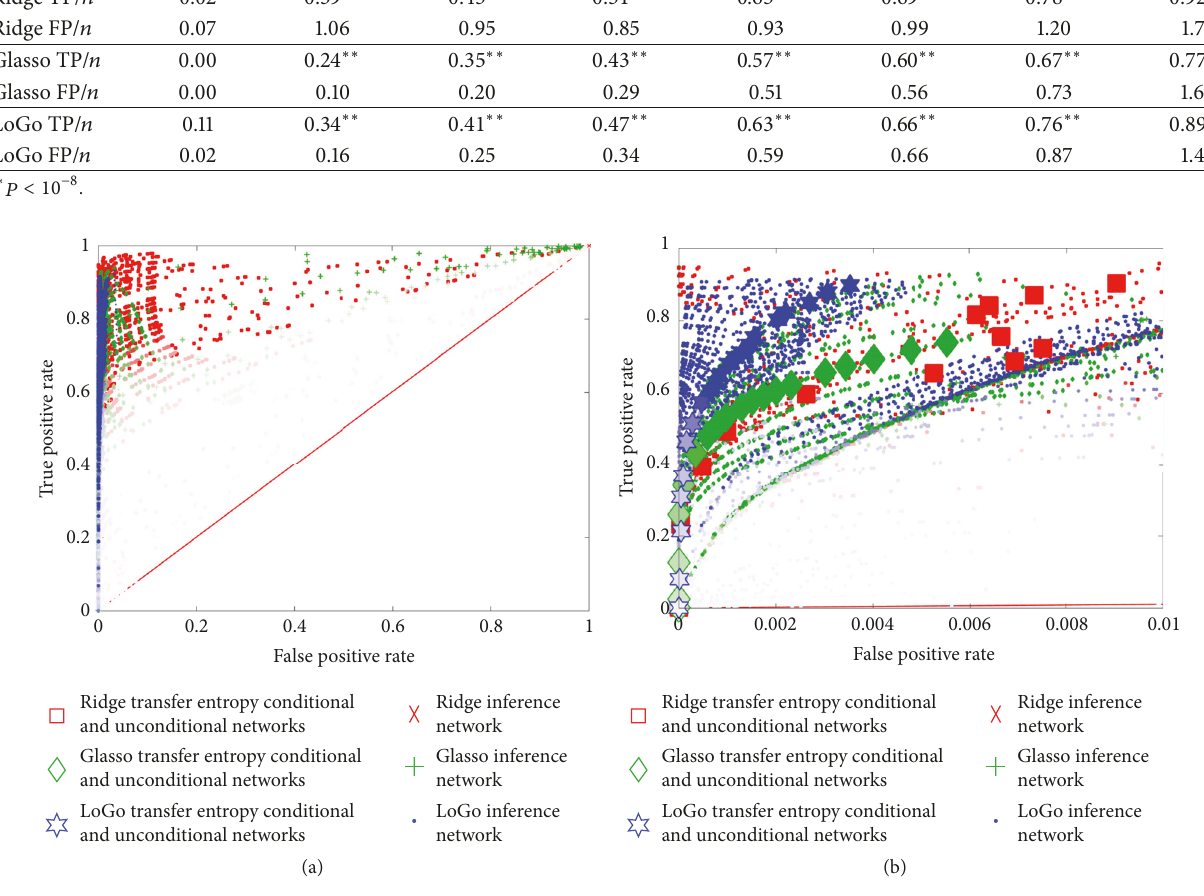
Figure 3: ROC values, for each model and each parameter combination . 𝑥 -axis false positive rates (FP /𝑚 ); 𝑦 -axis true positive rates (TP /𝑛 ). (a) and (b) are the same with 𝑥 -axis expanded on the low values only for (b) to better visualise the differences between the various models. Large symbols refer to 𝛾 = 0.1 and validation at 𝑝 value 𝑝 V = 0.01 . Color intensity is proportional to time series length. Inference network results are all outside the range of the plot. Reported values are averages over 100